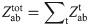
Schematic diagrams to show the recursive partition function calculation (in black) and the backtracking procedure (in red), for the total (A) and type LR (B) partition functions, respectively.For a given segment [a, b], we classify six types of conformations (t = coil, C, L, R, LR, M). The total partition function Zabtot=∑tZabt. The backtracking begins with P1Ntot=1.0 and proceeds differently for each type of conformational ensemble. As an example of the total conformational ensemble: the backtracking proceeds through Pabt=(Zabt/Zabtot)⋅Pabtot. Here, N is the RNA length and Zabcoil=1.0. The recursive relationship of other type of partition functions is shown in S1 Data